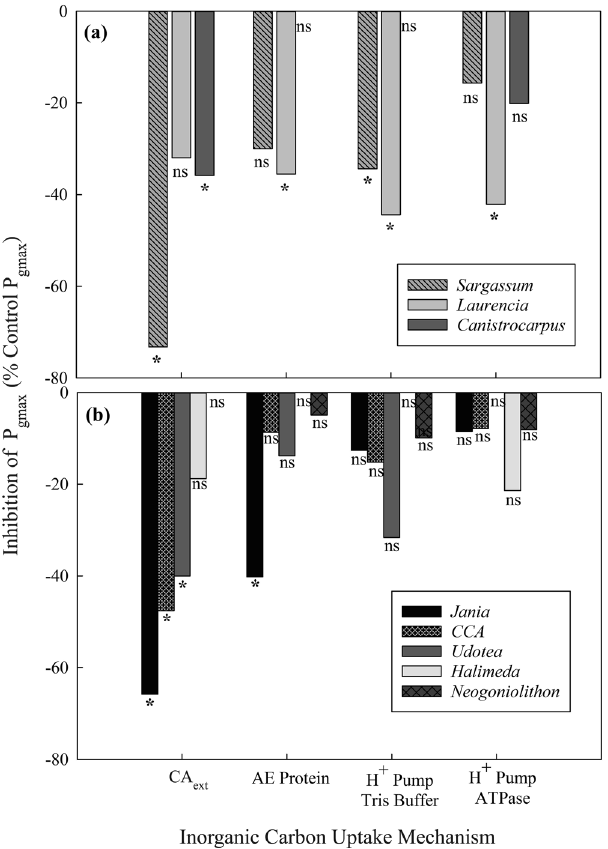
Figure 3. Inhibition of P gmax in three fleshy ( a ) and five calcifying ( b ) tropical macroalgae as inhibitor block various bicarbonate uptake pathways: external carbonic anhydrase (CA ext ) with acetazolamide (AZ), AE protein by pyridoxal (5) phosphate (PLP), proton pump acidification by Tris buffer and ATPase H + pumps by sodium